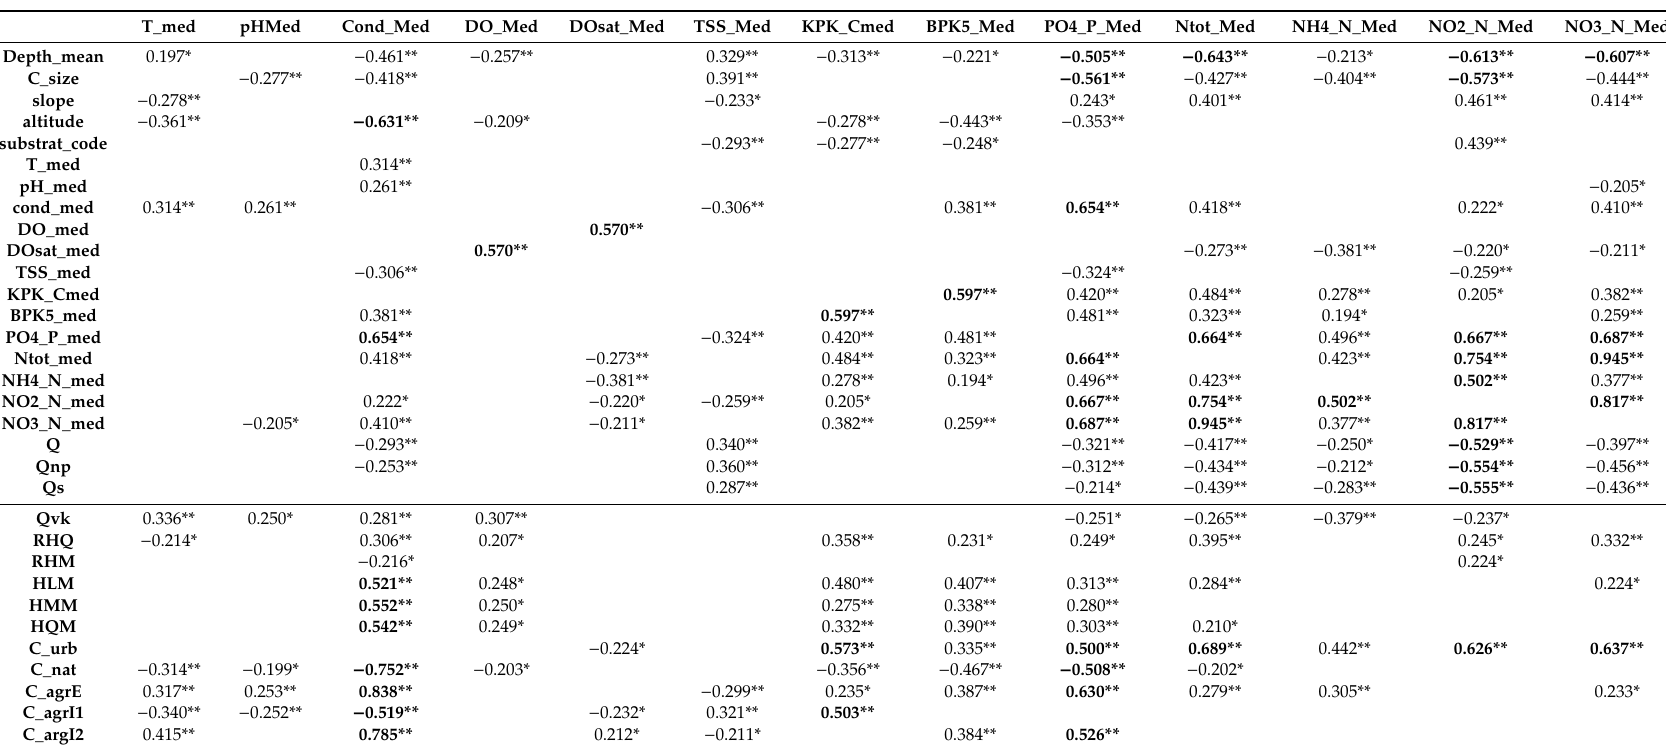
Table A4. Statistically significant Spearman’s correlation coe ffi cients (RSp) for the combinations of water quality variables with variables from all groups (** P < 0.01, * P < 0.05); | RSp | > 0.50 are in bold. See Table 2 for environmental variable codes.